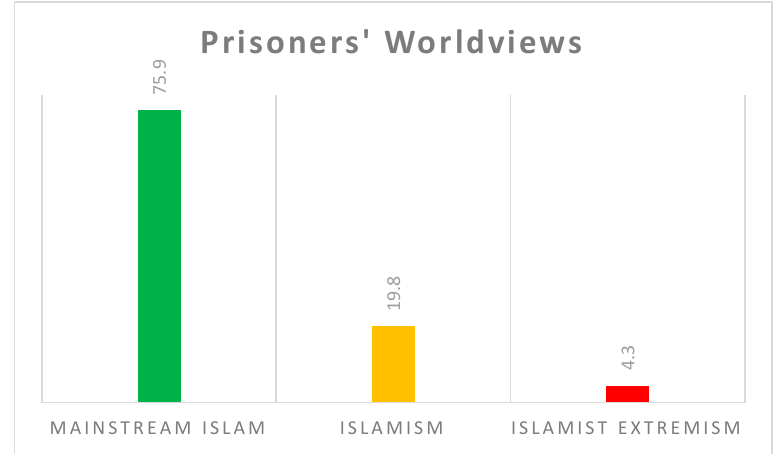
Figure 6. Basic Worldviews of the UCIP sample.